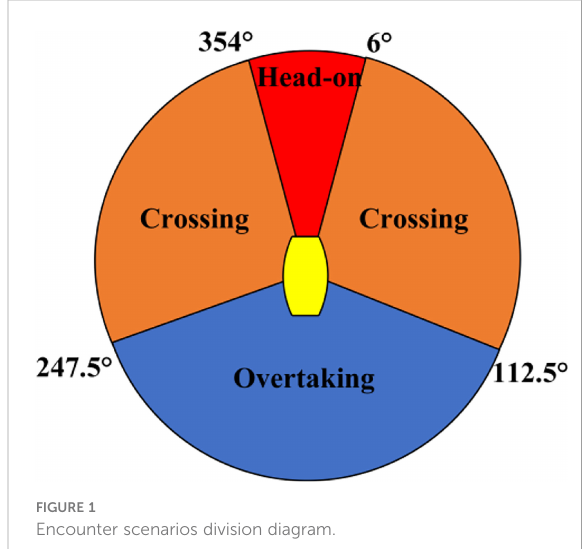
FIGURE 1 Encounter scenarios division